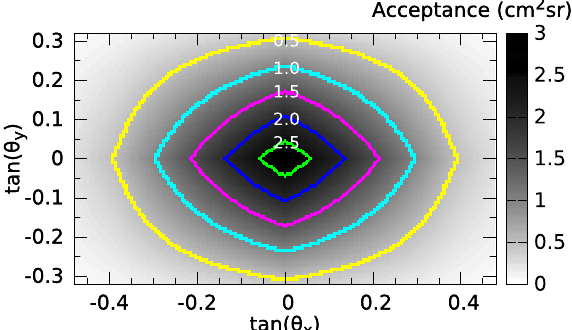
Figure 7. The total acceptance of ten tracking systems is shown as a function of horizontal and vertical track slopes with a bin size of approx. 5.5 mrad × 5.5 mrad. Coloured lines highlight equal values at the acceptance of 0.5 cm 2 sr (yellow), 1 cm 2 sr (cyan), 1.5 cm 2 sr (pink), 2 cm 2 sr (blue) and 2.5 cm 2 sr (green),